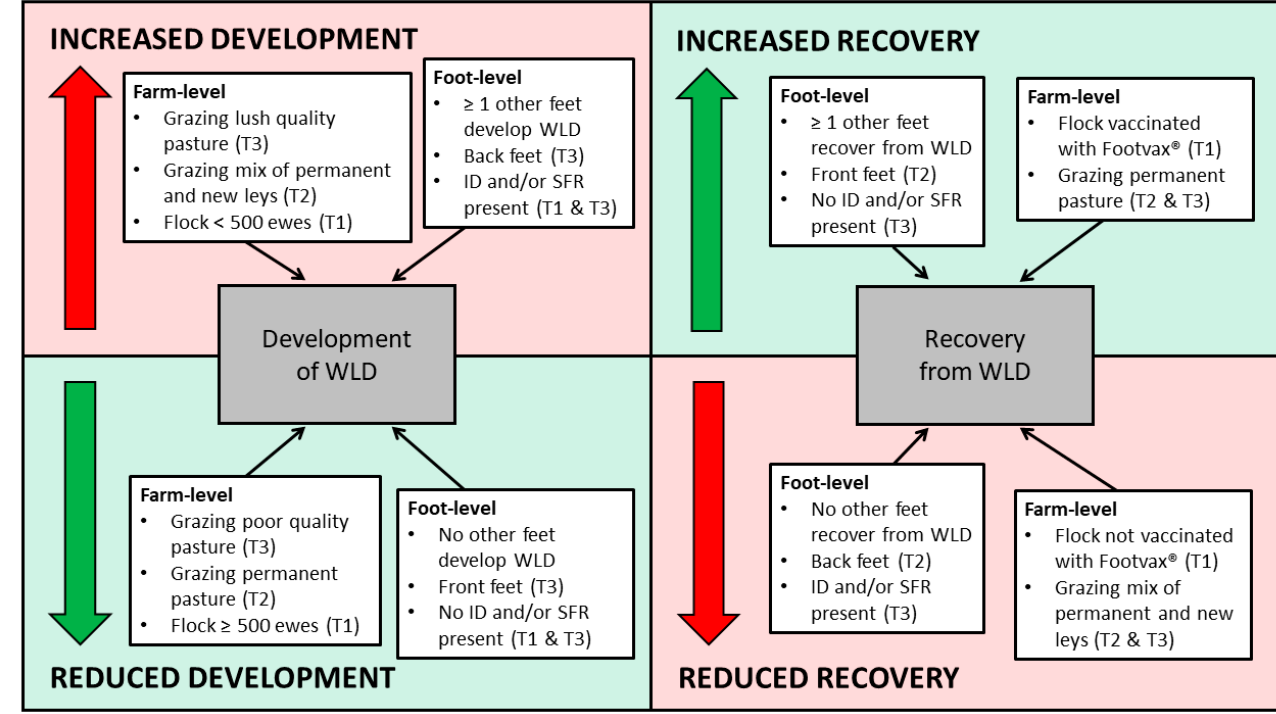
Figure 4. Summary of factors associated with the increased and reduced development of white line disease, and increased and reduced recovery from white line disease, at foot-level, and the number of feet affected. Brackets indicate the specific transition period.